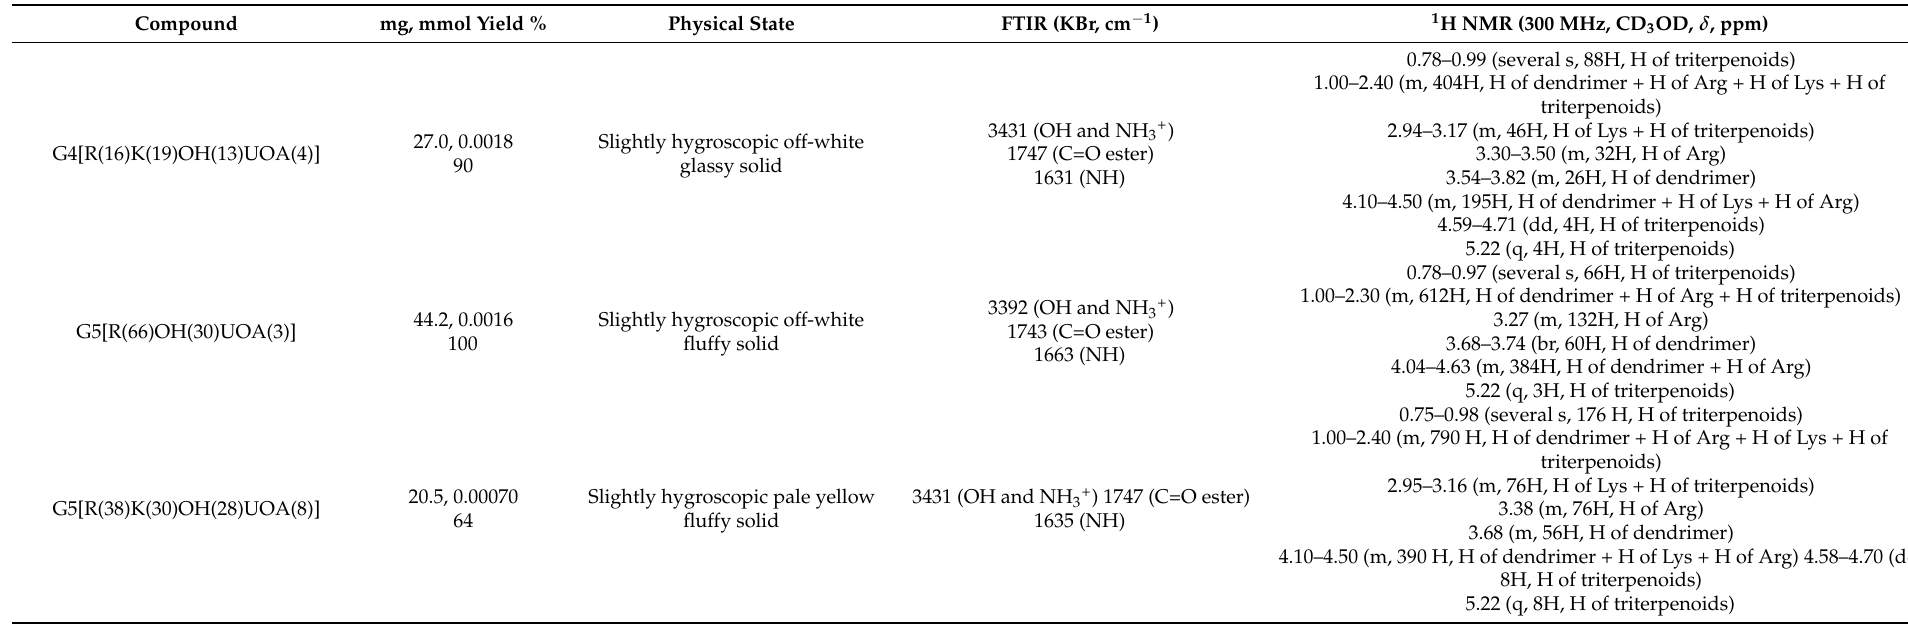
Table 1. Physicochemical properties and spectral data of the obatained G4 and G5 CDs conjugated with lysine, arginine and encapsulating ursolic and oleanolic acids (UOACDs).